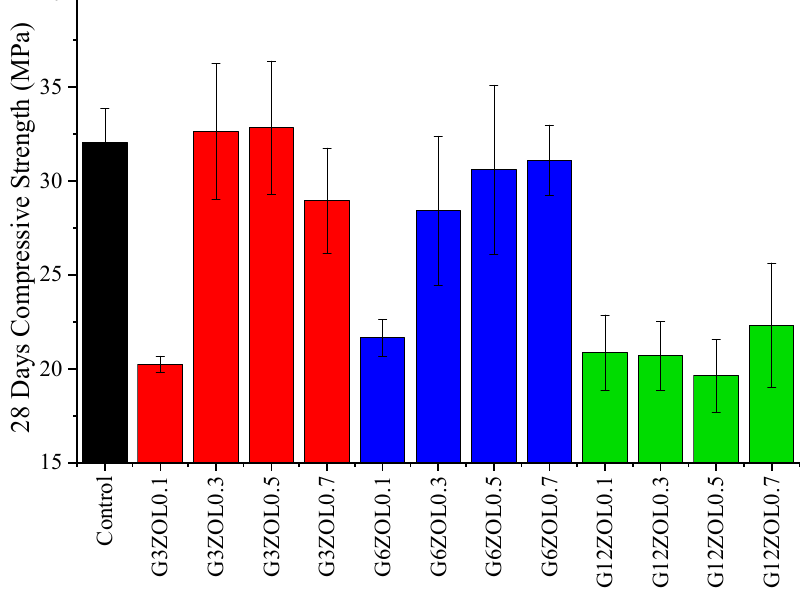
Figure 3. Compressive strength variation of the geopolymer mixes.